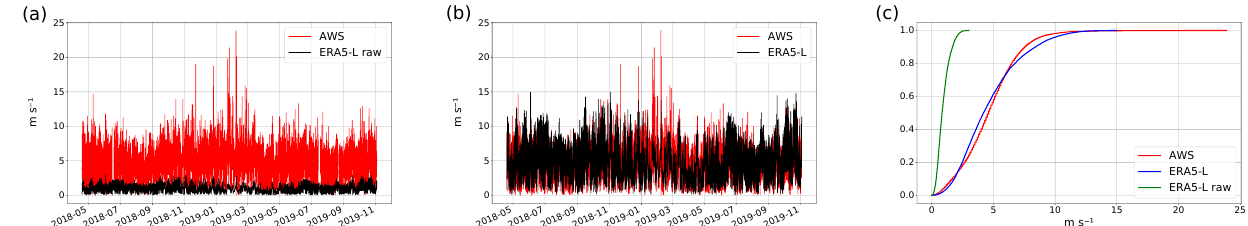
Figure 3. Measured (AWS) and ERA5-L wind speed at 2m. Time series without wind scaling ( a , ERA5-L-raw), with wind scaling ( b , ERA5-L), and the cumulative distribution functions ( c ) with unscaled and scaled ERA5-L wind speed at 2m. In all plots hourly values are displayed.